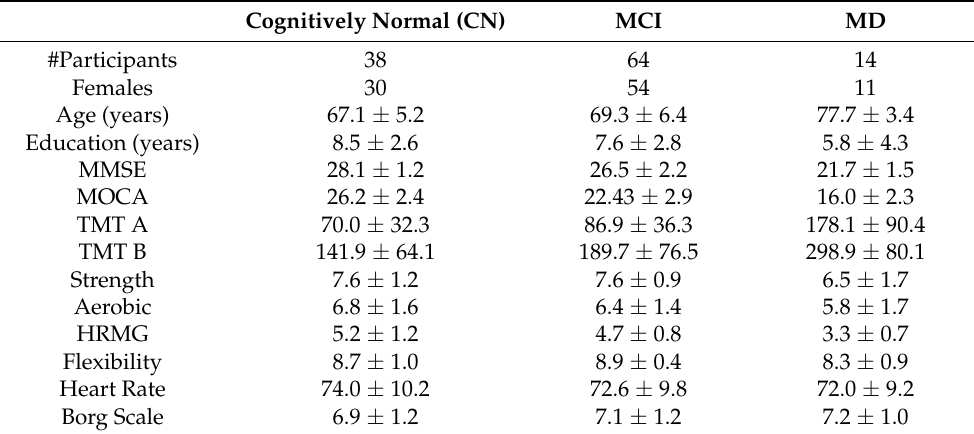
Table 2. Description of group demographics and assessment tests score per cognitive group (cognitive groups according to the clinical